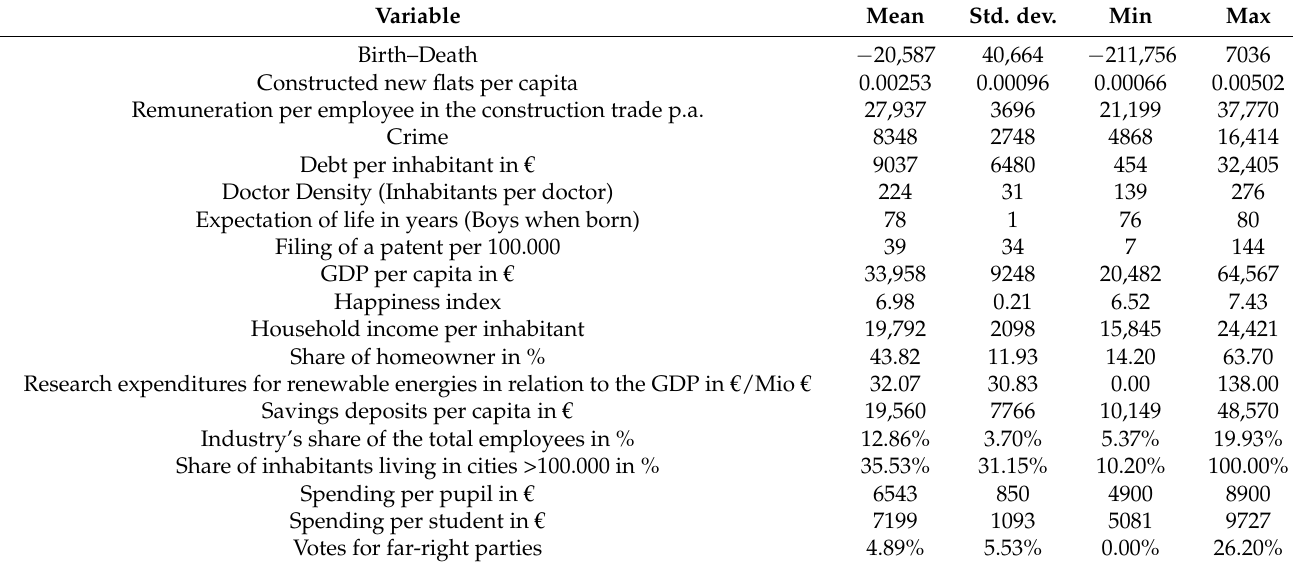
Table 2. Descriptive statistics for the 23